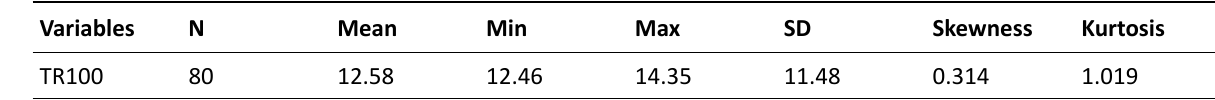
Table 2. Basic statistical parameters for the assessment of 100 sprints Variables